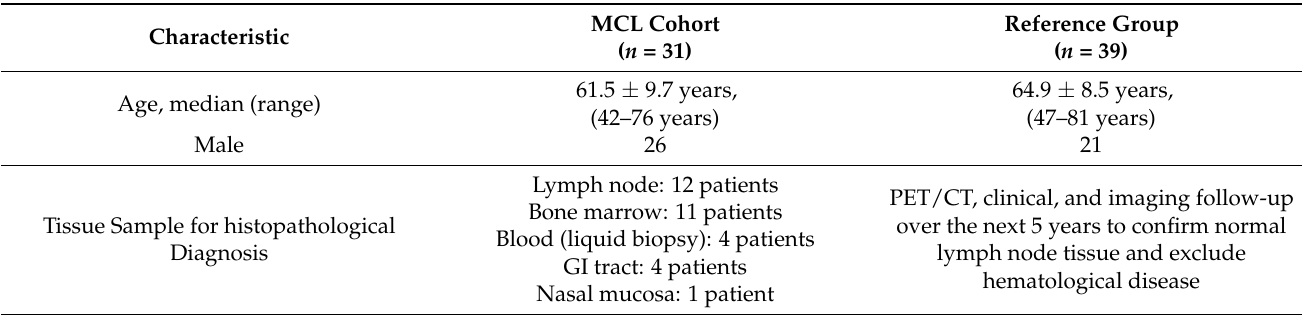
Table 1. Baseline demographic, clinical, laboratory, and biological data of the entire MCL cohort and the reference